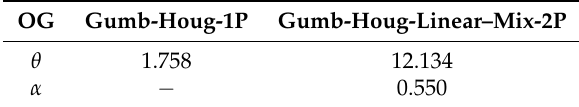
Table 9. Best-fit copulas parameters for the old generation.